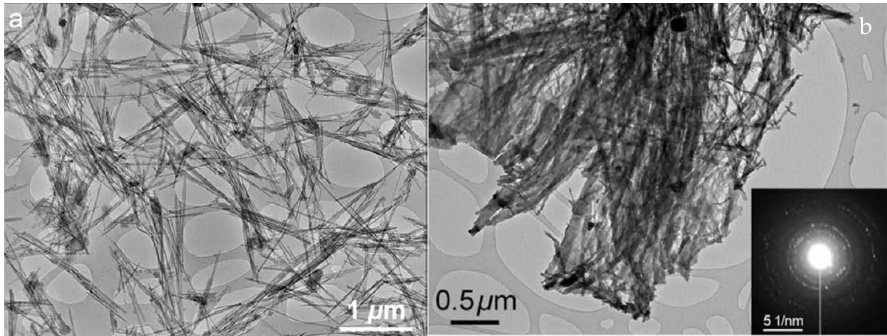
Figure 8. TEM images of untreated ( a ) and heat-treated clay nanopowders ( b